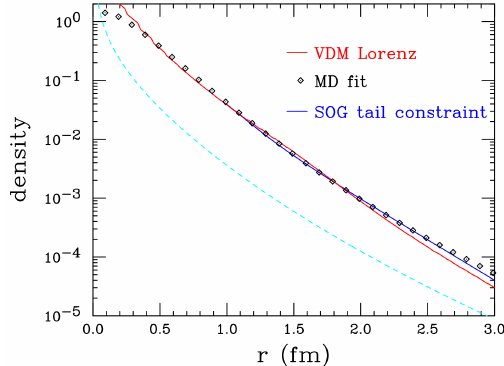
Figure 12. The experimental charge density, obtained from the Monopoles times Dipole (MD) fit ( (cid:5) ) of the world data, is compared to the tail of the SOG fit (blue) [65] and the density corresponding to the VDM fit of Lorenz et al. (red). Not shown for clarity: the density from [97]; see Section 6.6.